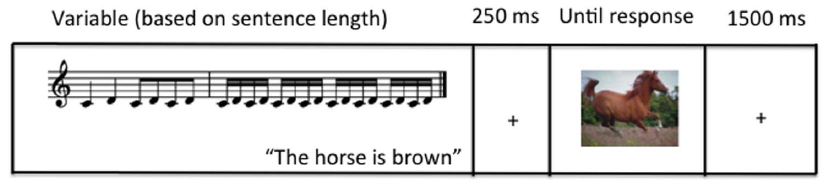
Figure 2. Sample trial from Experiment 2. In this particular trial, the musical motion (acceleration) matches the implied motion of the picture.